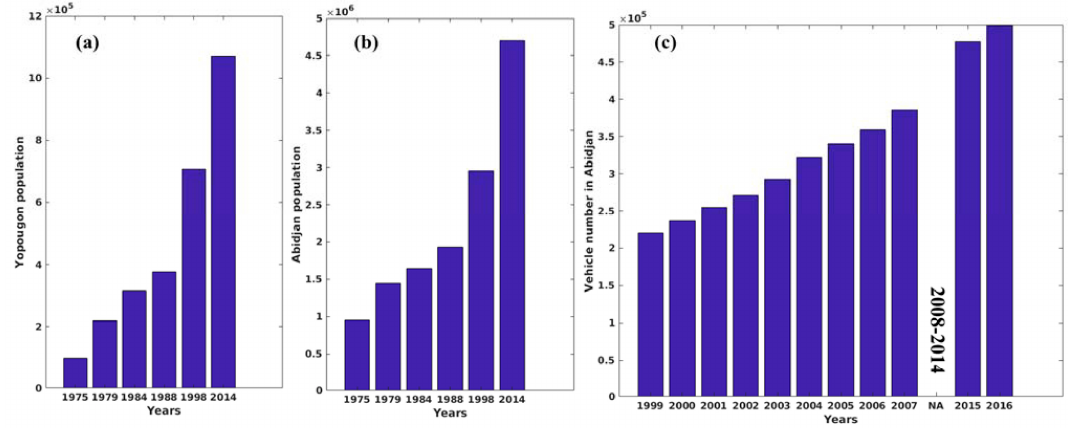
Figure 2. ( a ) Population growth in Yopougon; ( b ) Population growth in Abidjan and ( c ) Evolution of vehicle fleet in Abidjan [36–38] (Désiré, 2012; SICTA, 2008, 2016). Missing data (Not available (NA)) between 2008 and 2014.